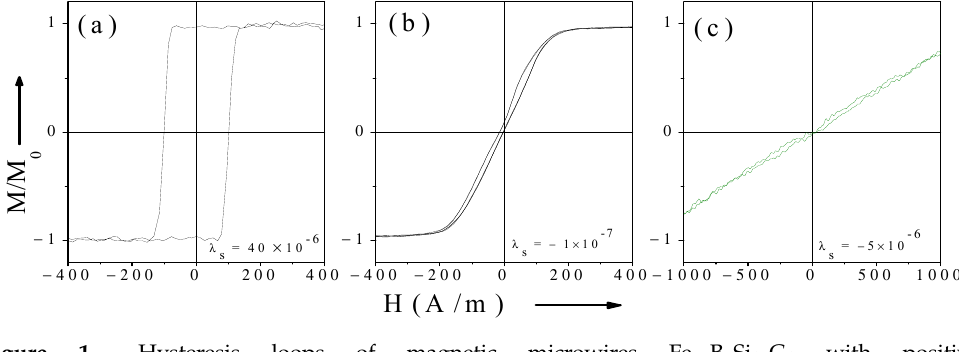
Figure 1. Hysteresis loops of magnetic microwires Fe 75 B 9 Si 12 C 4 with positive ( a ) Co 67.1 Fe 3.8 Ni 1.4 Si 14.5 B 11.5 Mo 1.7 with vanishing ( b ) and Co 77.5 Si 15 B 7.5 with negative ( c ) λ s values. (Reproduced with permission from [42] Open Access Copyright © 2019 MDPI).